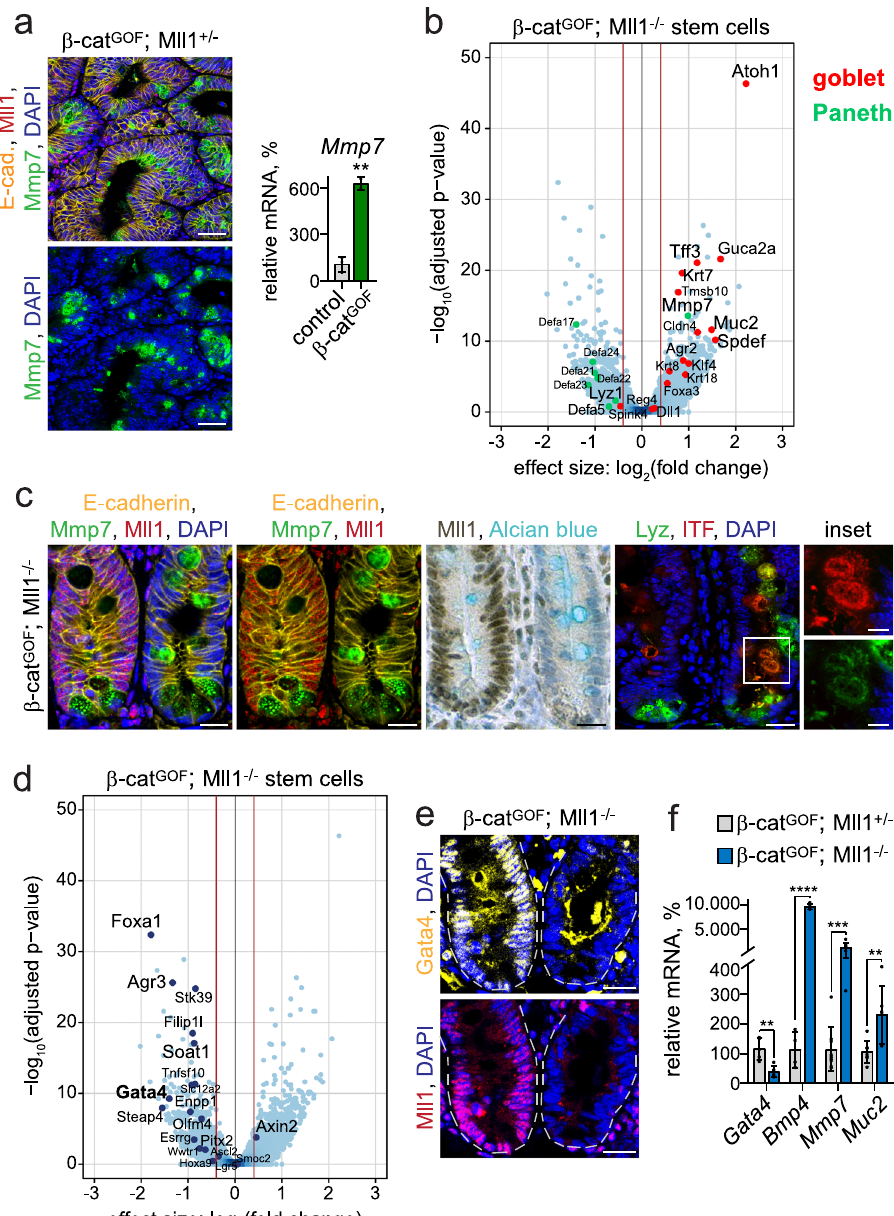
Fig. 3 The ablation of Mll1 induces differentiation. a Left: Immunostaining for Mmp7 (green) and Mll1 (red) on β -cat GOF ; Mll1 + / − tumor sections, scale bars 50 µ m. Nuclei stained with DAPI (blue), E-cadherin (yellow) stains cell borders. Right: mRNA expression of Mmp7 in control and β -cat GOF intestines, n = 3 independent mice, two-tailed unpaired t -test, ** p = 0.0012. Data are presented as mean values ± SD. b Volcano plot of differentially expressed genes in β -cat GOF ; Mll1 − / − relative to β -cat GOF ; Mll1 + / − Lgr5-GFP + stem cells isolated from four independent mice each, represented as blue dots. Cut-off log 2 fold-change ≥ 0.5. Goblet and Paneth cell-speci fi c genes 78 are marked in red and green, respectively, and indicated by names. c Immunostaining on sections of adjacent non-recombined (left) and recombined (right) small intestinal crypts in β -cat GOF ; Mll1 − / − mice, left: for Mmp7 (green) and Mll1 (red), middle: for Mll1 (brown) and Alcian blue; nuclear counterstaining with hematoxylin. Right: immunostaining for Lyz (green) and ITF (red), scale bar 20 µ m. Insets on the right: magni fi cations of mutant double-positive cells, scale bars 10 µ m. Nuclei stained with DAPI (blue), E-cadherin (yellow) stains cell borders. Stainings were performed in two independent mice per genotype. d Volcano plot of differentially expressed stem cell genes and transcription factors in β -cat GOF ; Mll1 − / − relative to β -cat GOF ; Mll1 + / − Lgr5-GFP + stem cells isolated from four independent mice each, represented as dark blue dots. Cut-off log 2 fold-change ≥ 0.5. e Immunostaining for Gata4 (yellow, upper panel) and Mll1 (red, lower panel) on sections of adjacent non-recombined (left) and recombined (right) small intestinal crypts in β -cat GOF ; Mll1 − / − mice, scale bars 20 µ m. Nuclei stained with DAPI (blue). Stainings were performed on sections of six independent mice. f mRNA expression of Gata4 , Bmp4 ( n = 4 independent experiments) and the secretory differentiation markers Mmp7 and Muc2 ( n = 7 independent experiments) in β -cat GOF ; Mll1 + / − and β -cat GOF ; Mll1 − / − organoids, two-tailed unpaired t -test, Gata4 ** p = 0.0032, Bmp4 **** p < 0.0001, Mmp7 *** p = 0.001, Muc2 ** p = 0.0096. Data are presented as mean values± SD. Source data are provided as a Source Data fi